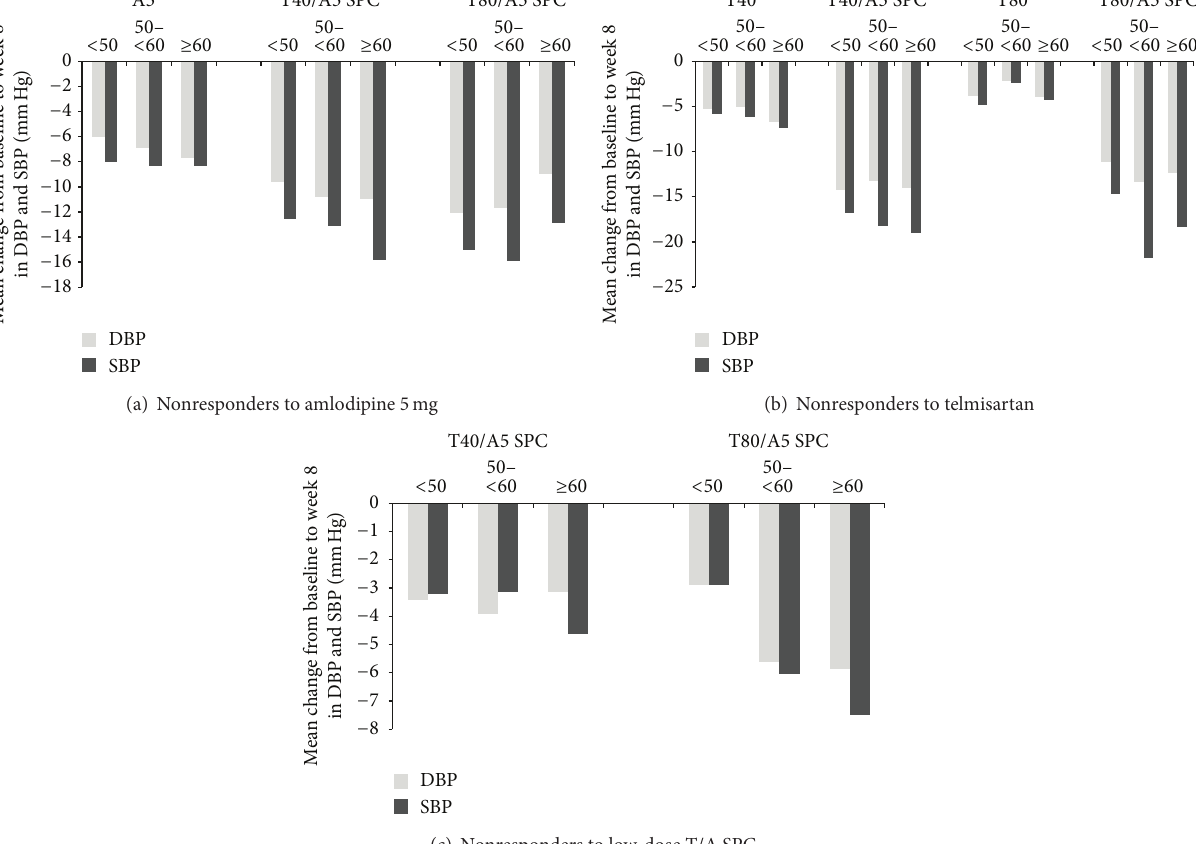
Figure 2: Change from baseline in DBP and SBP by age group in the three groups after 8 weeks’ treatment. Baseline indicates reference baseline BP value, which was measured immediately before first dosing in the double-blind treatment period. A5: amlodipine 5 mg; BP: blood pressure; DBP: diastolic blood pressure; SBP: systolic blood pressure; SPC: single-pill combination; T/A: telmisartan/amlodipine; T40: telmisartan 40 mg; T80: telmisartan 80